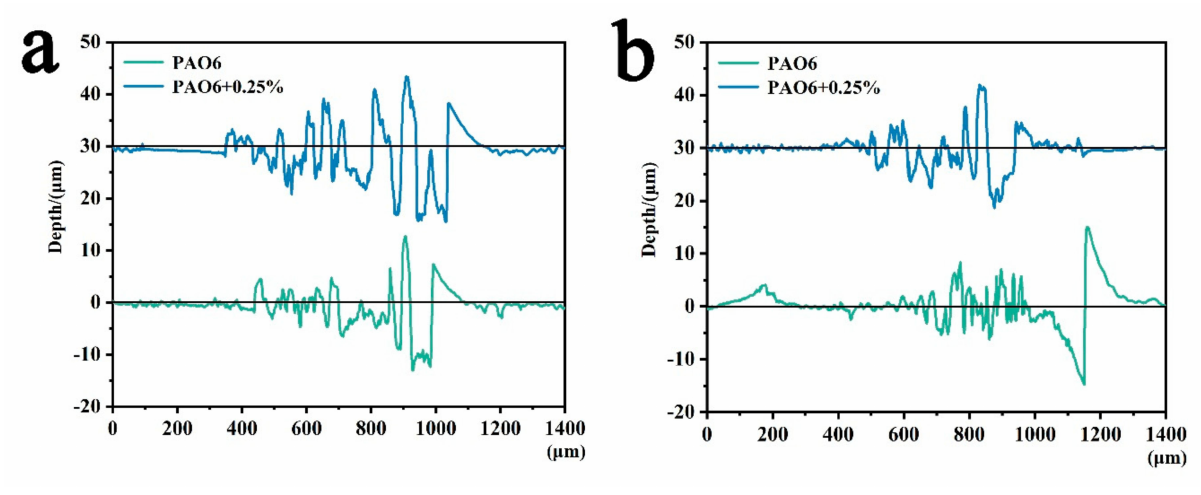
Figure 7. Wear profile curve of pure PAO6 and 0.25 wt% IF–WS 2 /PAO6 at 75 °C ( a ) and 100 °C ( b